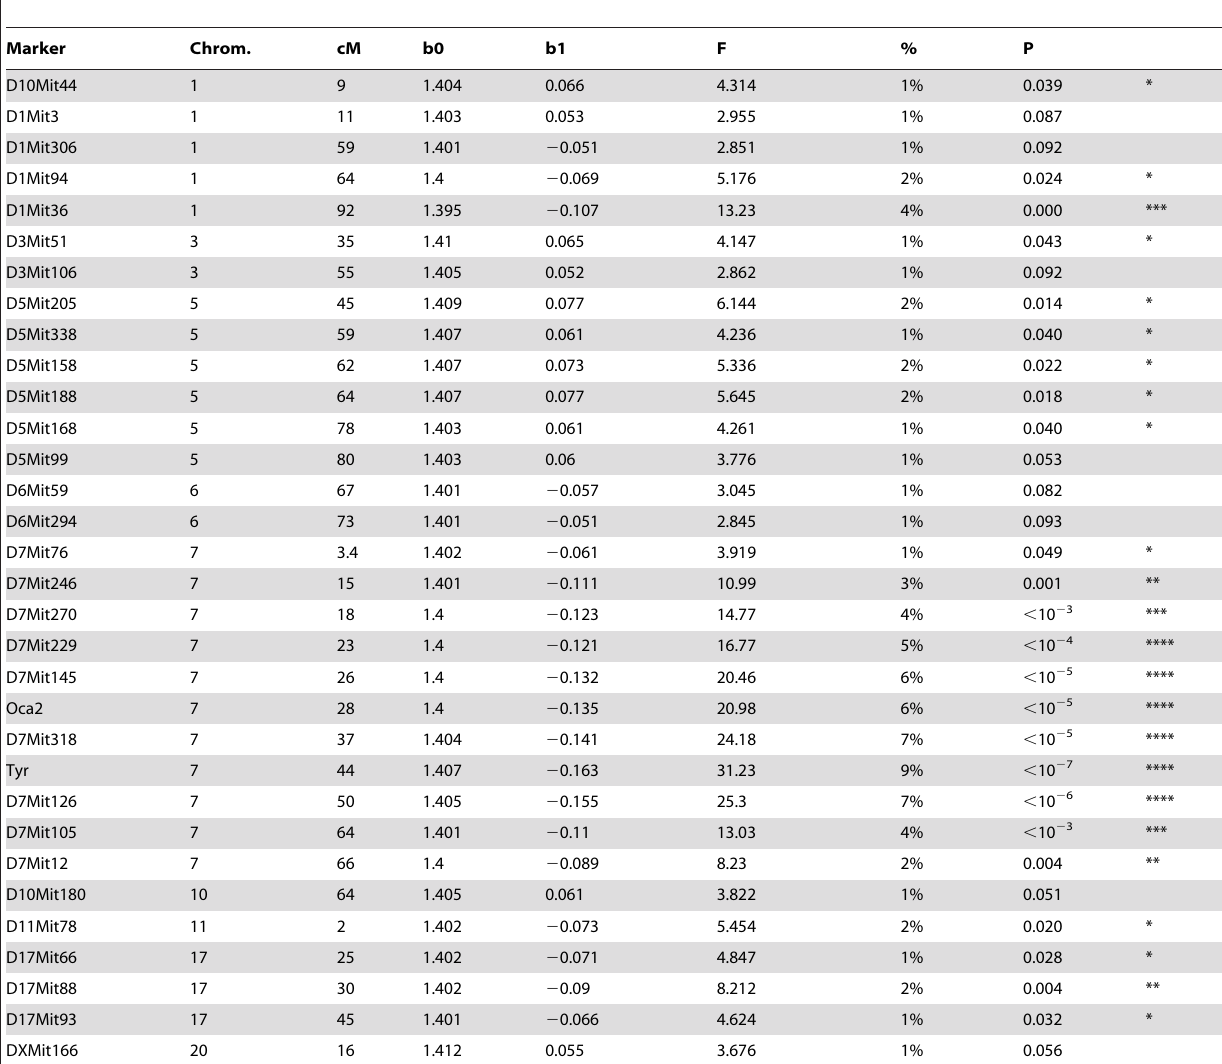
Table 3. Markers showing near-significant and significant association with bFGF-induced corneal neovascularization in a C57BL/ 6J 6 SJL/J F2 cross.